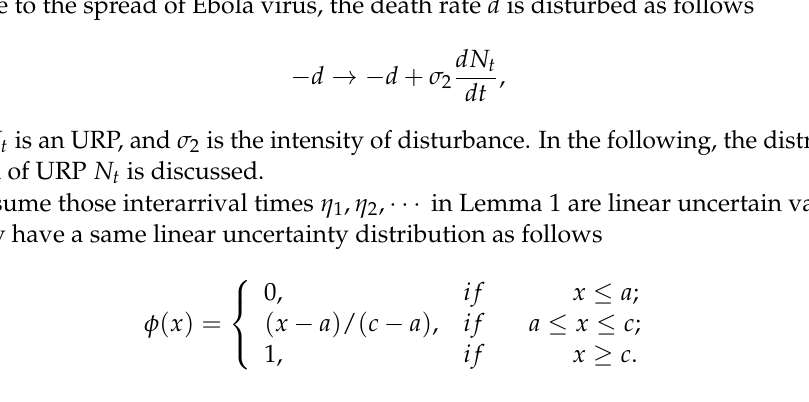
Figure 1. Uncertain distribution ( )